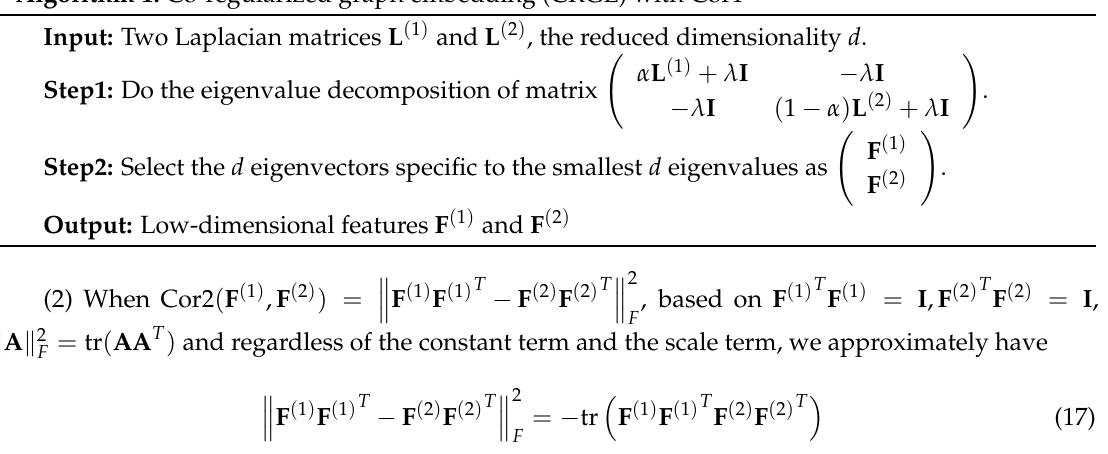
Algorithm 1: Co-regularized graph embedding (CRGE) with